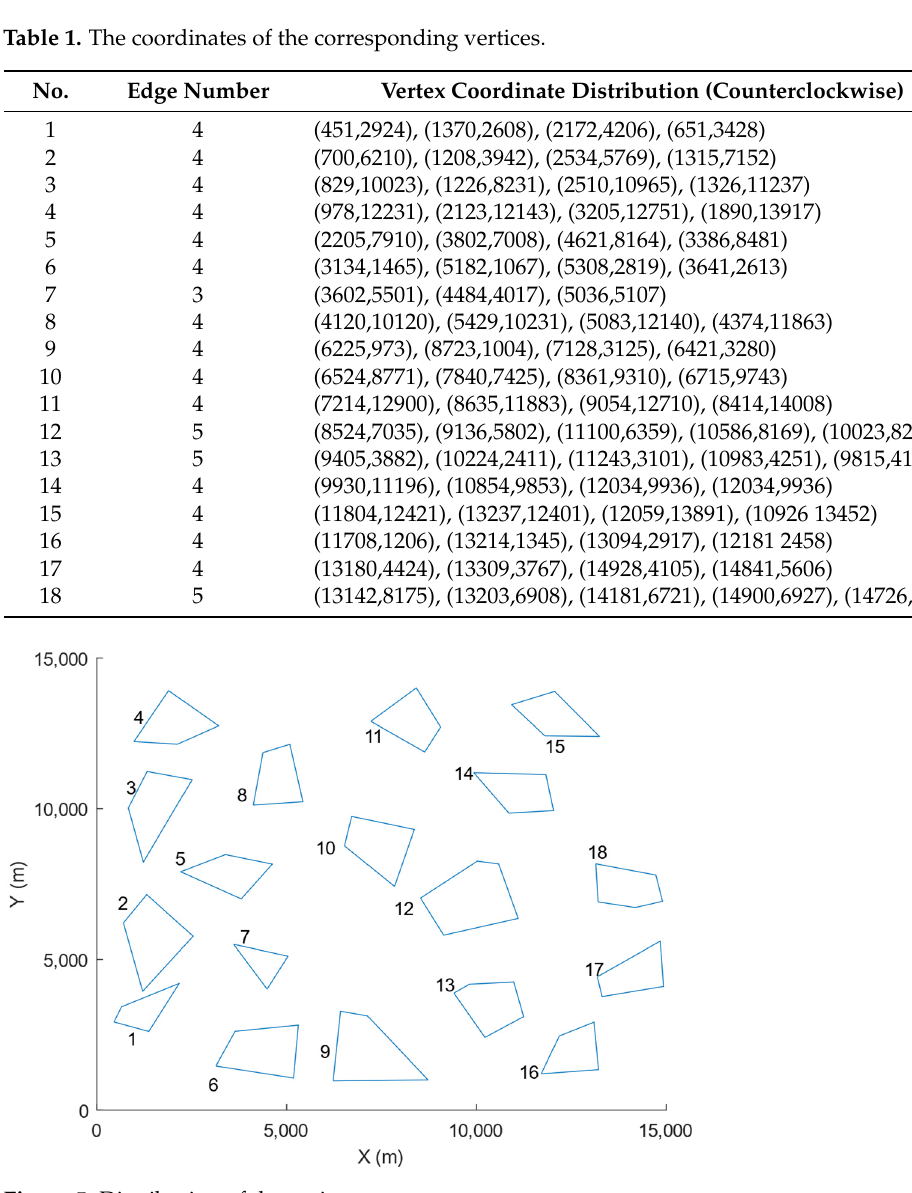
Figure 5. Distribution of the regions. Table 2. The performance parameters for homogeneous and heterogeneous